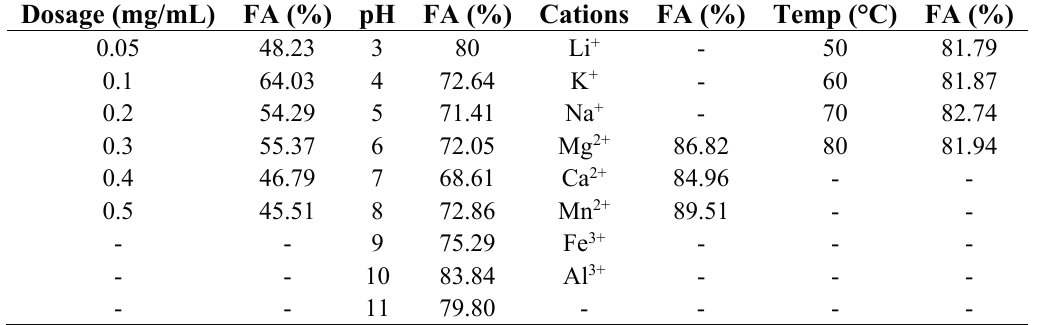
Table 2. Effect of dosage, pH, cations and temperature on the flocculating activity of purified REG-6. Dosage